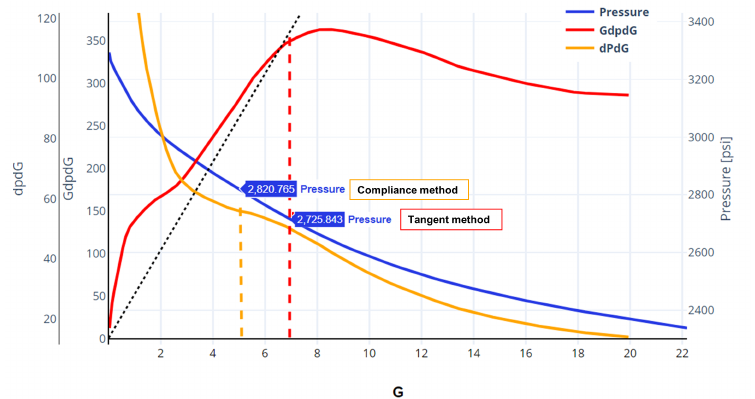
Figure 20. Analysis of cycle 2.1 using tangent and compliance